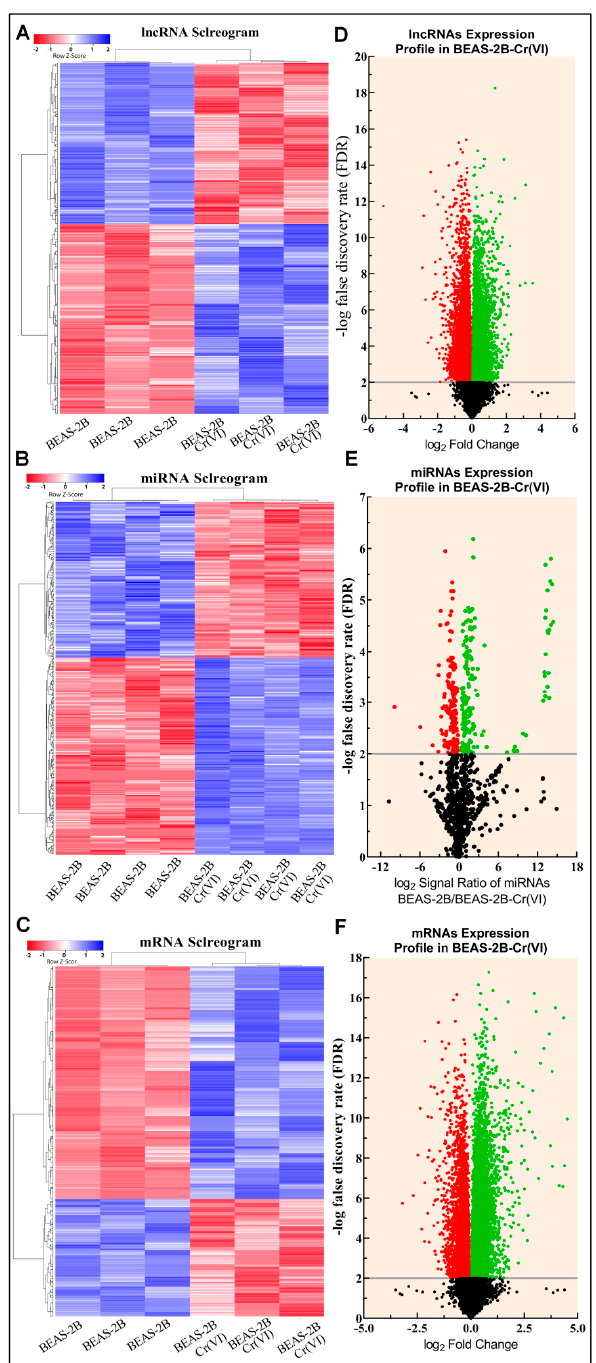
Figure 1. Transcriptomic profiles of BEAS-2B-Control and BEAS-2B-Cr(VI) cells. ( A – C ) Hierarchical clustering correlogram of DE lncRNA, miRNA, and mRNA transcripts, respectively. In the two-color system, blue indicates increased expression, while red indicates decreased expression. ( D – F ) Volcano graphs show the DE RNA transcripts of the lncRNA, miRNA, and mRNA transcripts, respectively. The significantly up-regulated candidates are marked by green dots; the significantly down-regulated candidates are marked by red dots whereas the non-significant candidates are marked by black dots under the gray